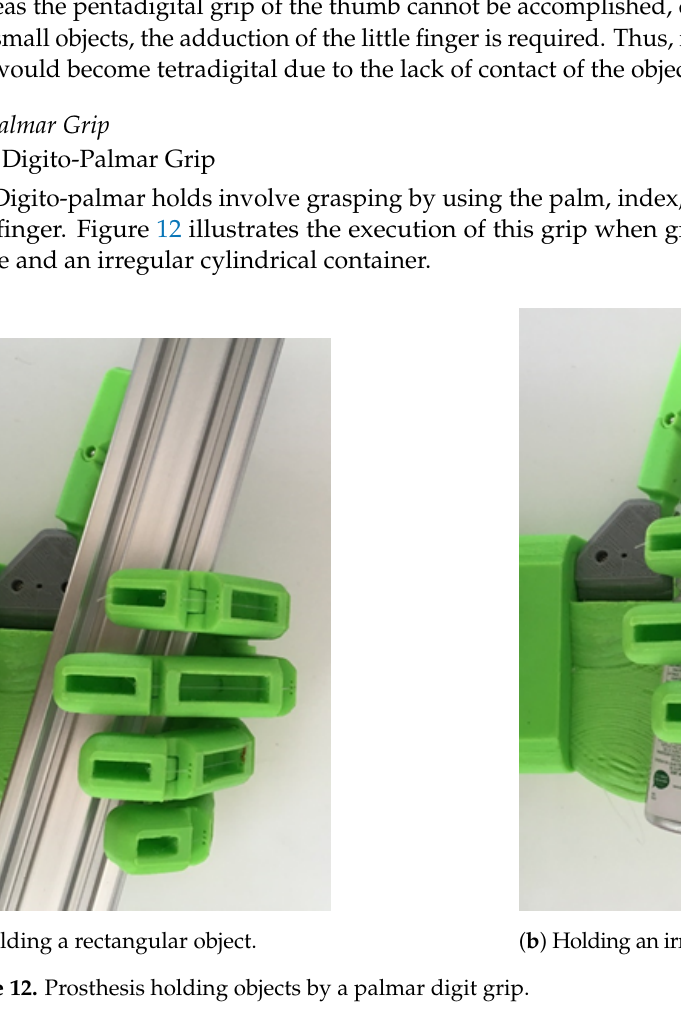
Figure 12. Prosthesis holding objects by a palmar digit